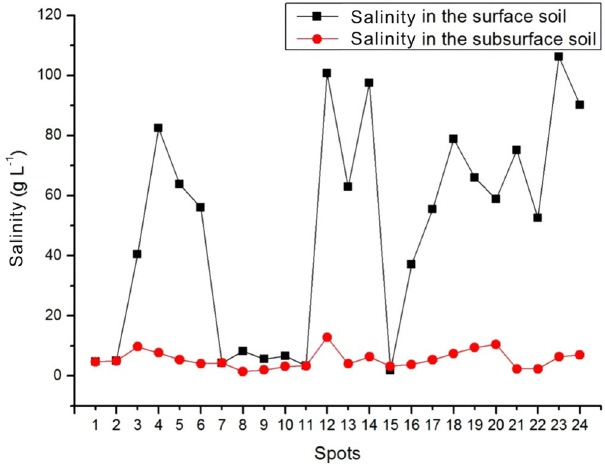
Figure 2. The distribution of soil salinity.